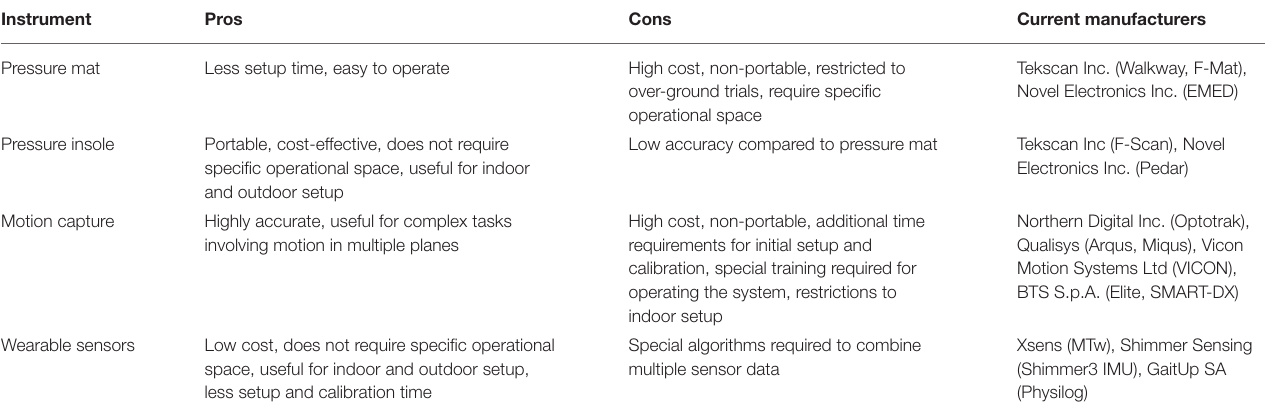
TABLE 5 | Gait analysis instruments, advantages, disadvantages, and current manufacturers.